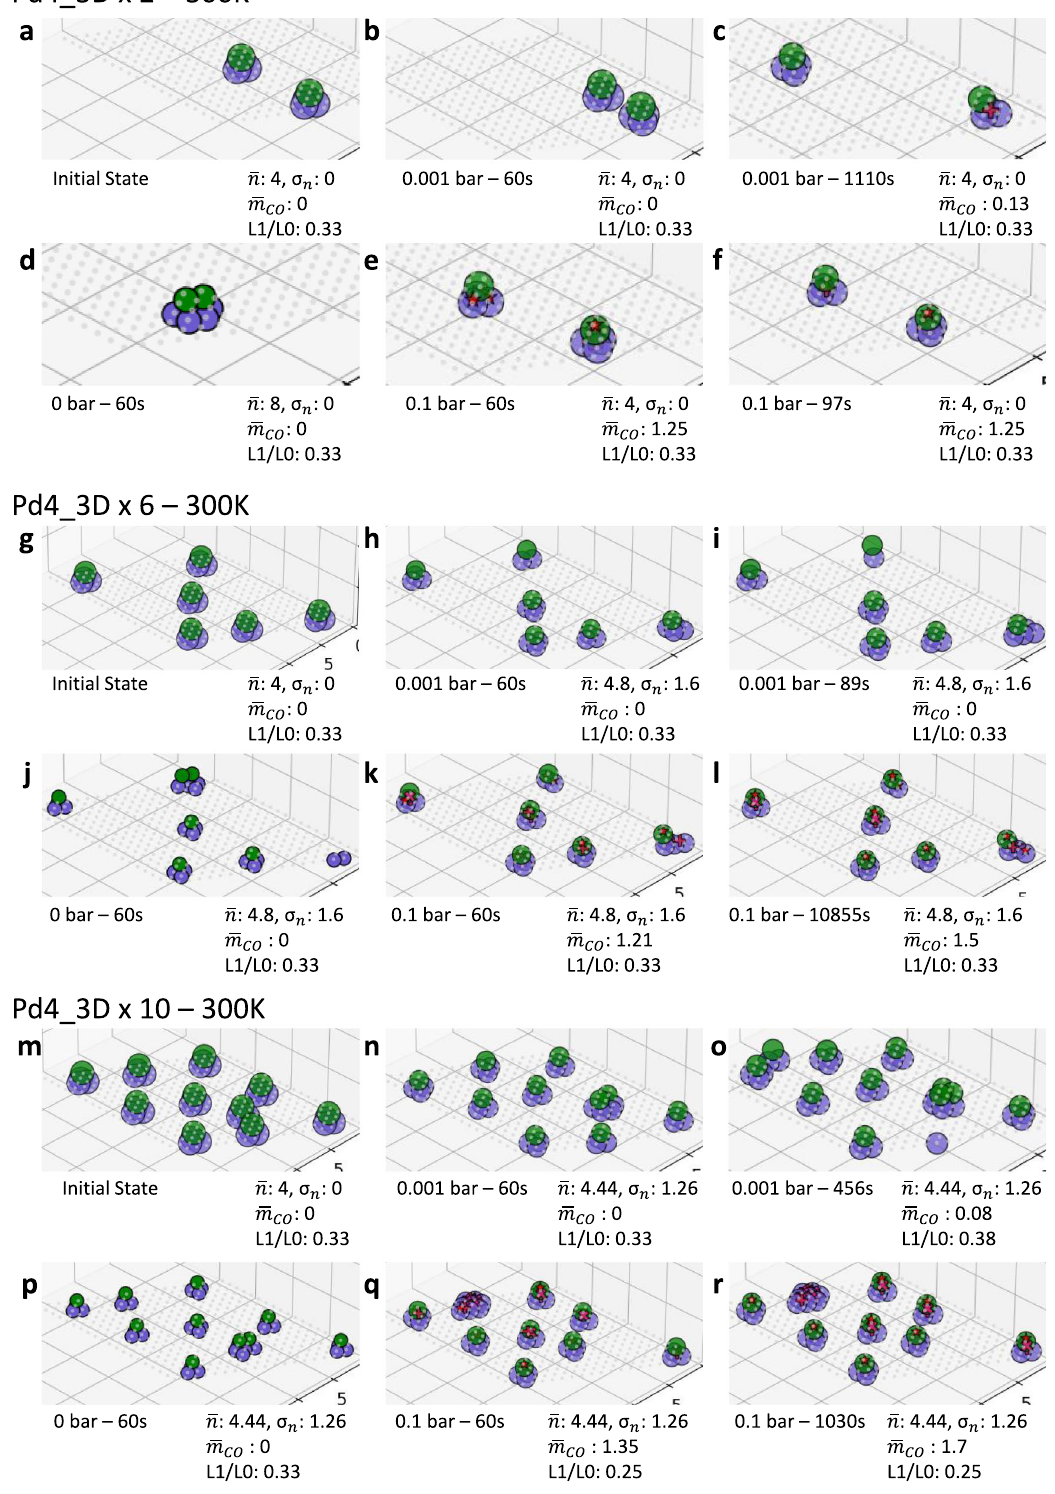
Fig. 5 Effect of pre-sintering and CO partial pressure on catalyst dynamics at 300 K. Initial state of ( a – f ) 2, ( g – l ) 6, ( m – r ) 10 Pd 4 _3d clusters at 300 K. (coverages of 0.02, 0.06, and 0.1 or 0.23, 0.69, and 1.15